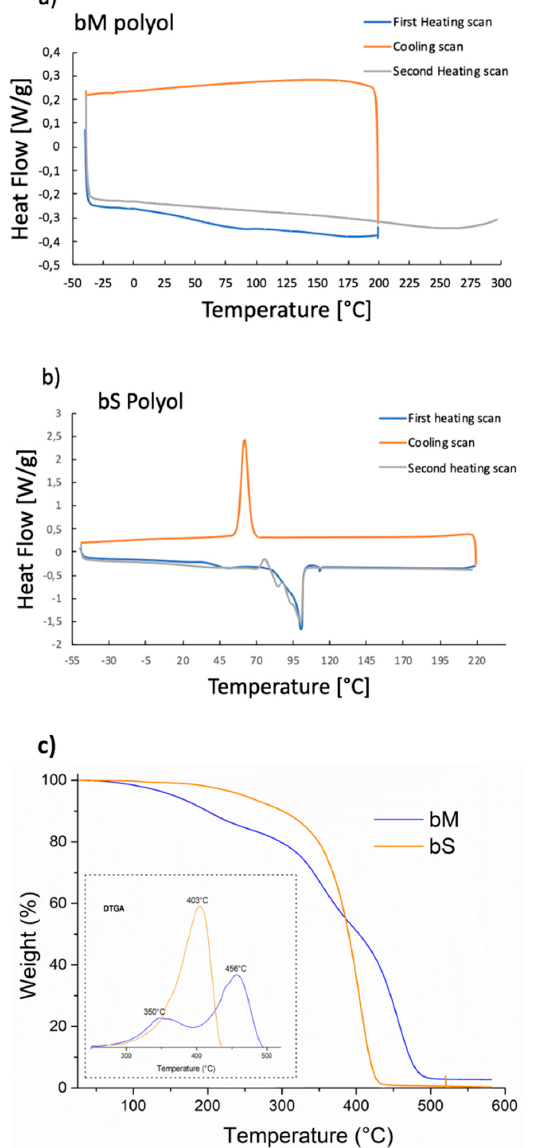
Figure 5. ( a ) Differential scanning calorimetry (DSC) of bM polyol. ( b ) DSC of bS polyol. ( c ) Thermal gravimetric analysis (TGA) and derivative TGA (DTGA) of bM and bS polyols. Table 3. Characteristics of bS and bM polyols.